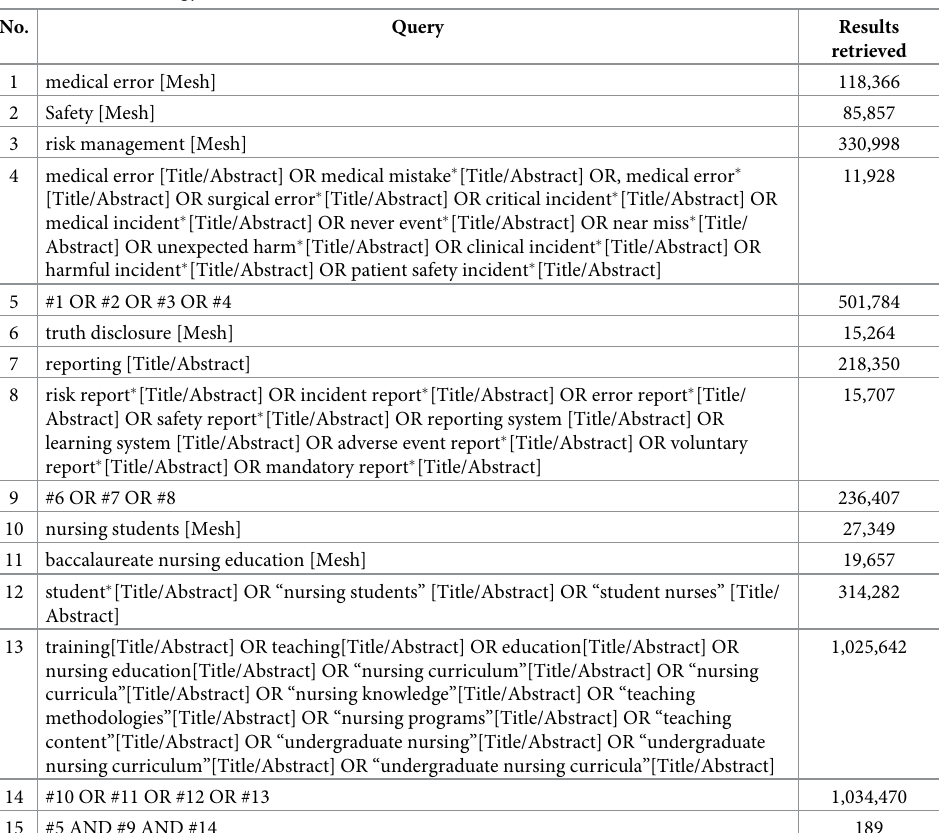
Table 1. Search strategy for MEDLINE